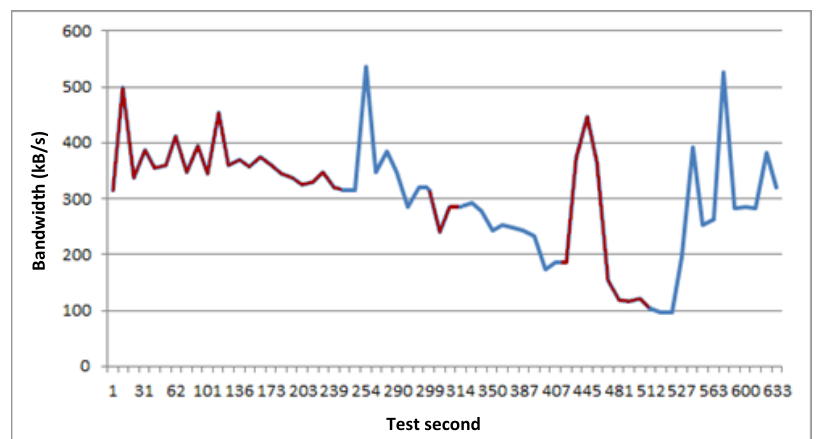
Figure 5. Bandwidth of the active link.